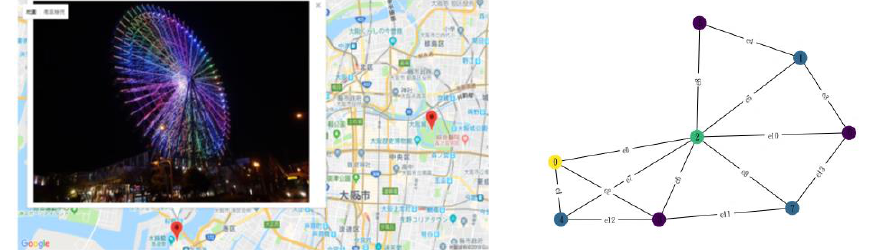
Fig. 3. Projects based on interdisciplinary knowledge and